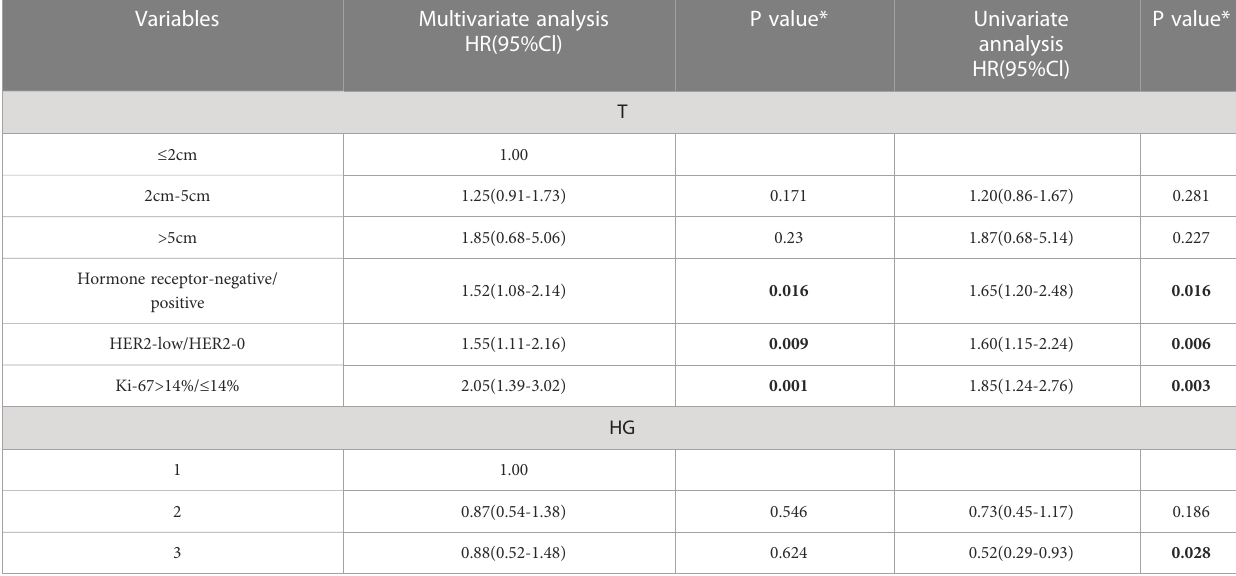
TABLE 4 Univariate and multivariate analyses for disease-free survival in the Lymph node-negative population.